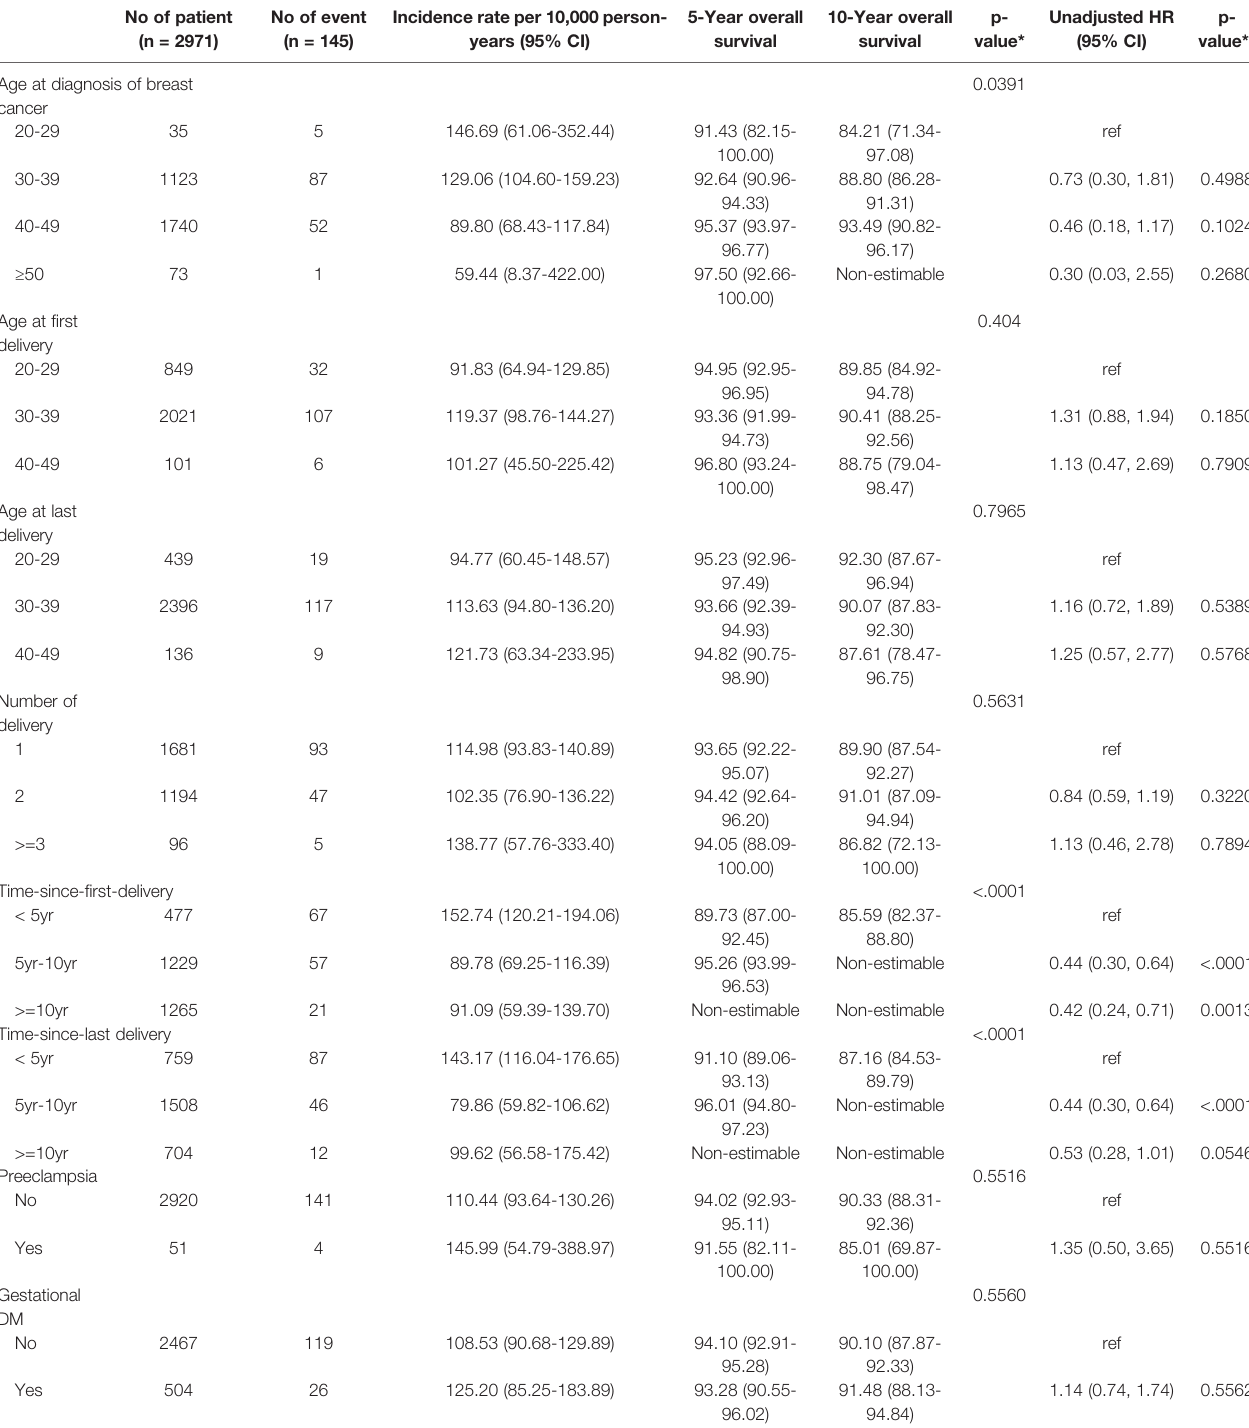
TABLE 4 | Univariate analysis of survival (overall survival) for breast cancer patients. No of patient (n =